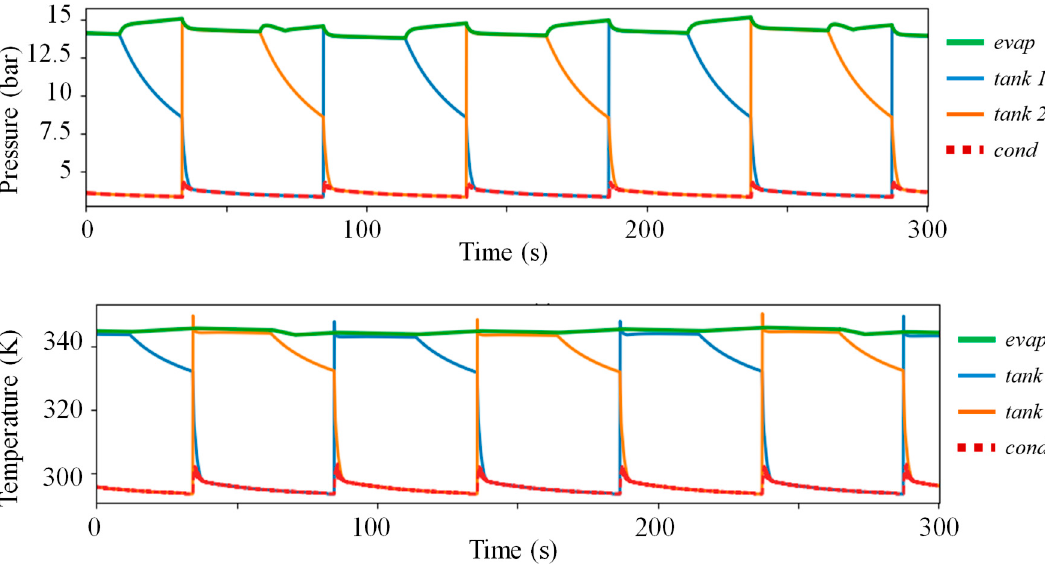
Figure 15. Simulated temperature and pressure evolutions of the vapor contained in the tanks over several cycles, considering a constant thermal power at the evaporator.